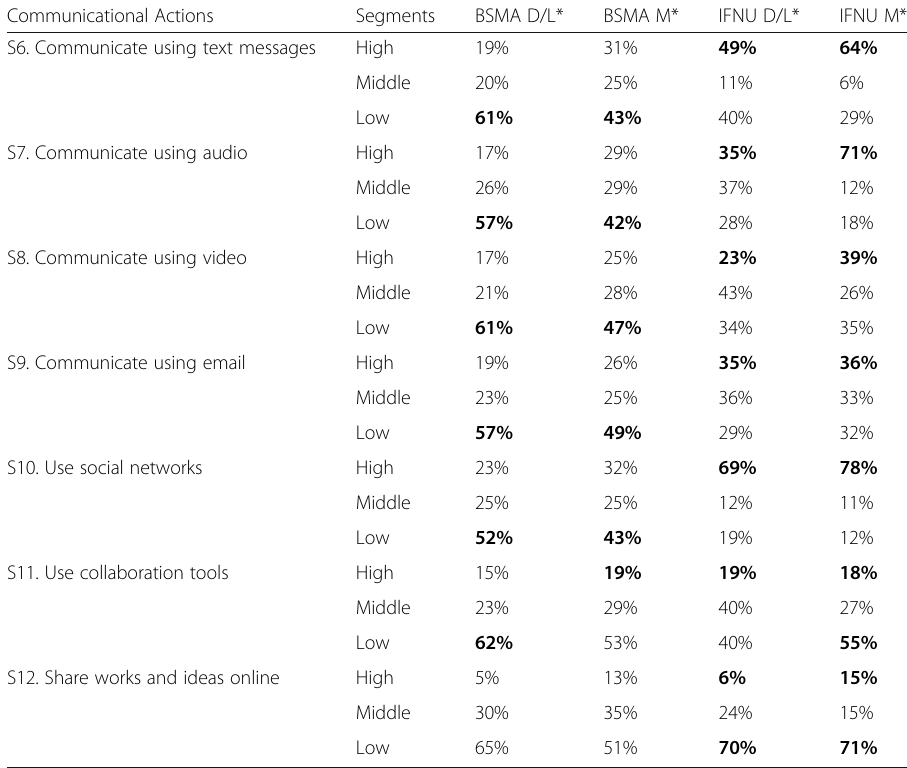
Table 3 Digital readiness segments for communicational actions Communicational